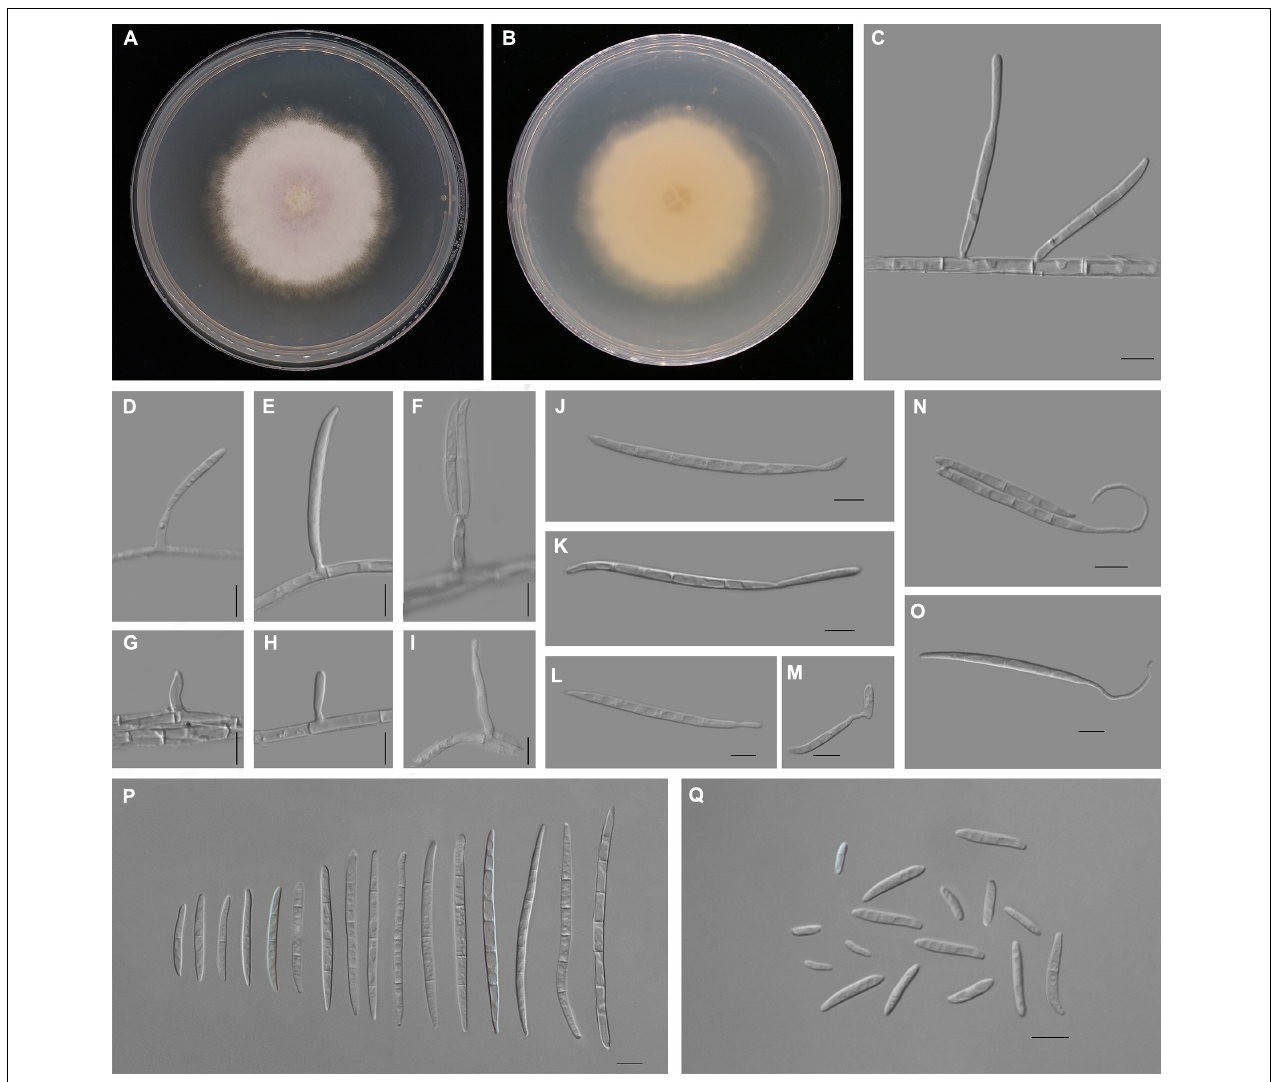
FIGURE 4 | Fusarium aglaonematis (ZHKUCC 22-0077). (A,B) Culture characteristics on potato dextrose agar (PDA) after 7 days [ (A) upper view; (B) reverse view]. (C) Macroconidia with up-dip attachment from mycelium. (D–F) Phialides with aerial macroconidia. (G–I) Phialides of aerial microconidia. (J–M) Macroconidia with up-dip attachment. (N,O) Macroconidia germination. (P) Aerial macroconidia. (Q) Aerial microconidia. Scale bars: (C–Q) = 10 µ